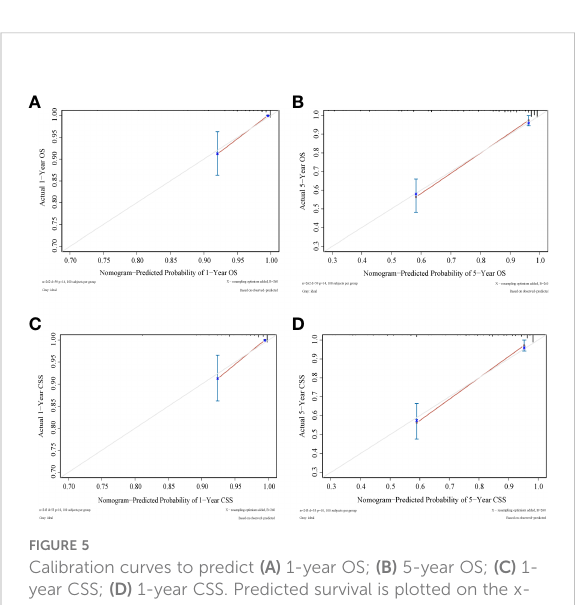
FIGURE 7 Kaplan-Meier curve of overall survival strati fi ed by (A) age, (B) site, (C) stage, (D) histology, (E) radiotherapy, (F) cancer-directed surgery.